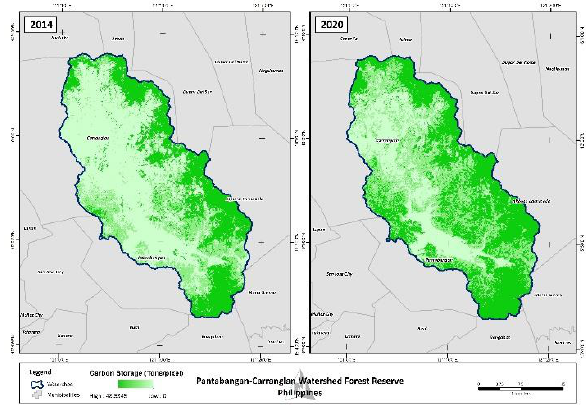
Figure 6. Estimated potential carbon stock in Pantangan- Carranglan Watershed for years 2014 and 2020.